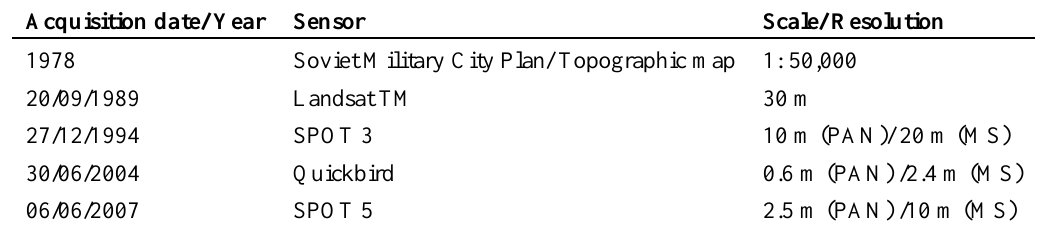
Table 1. The following data were used in this study and included satellite imagery and a